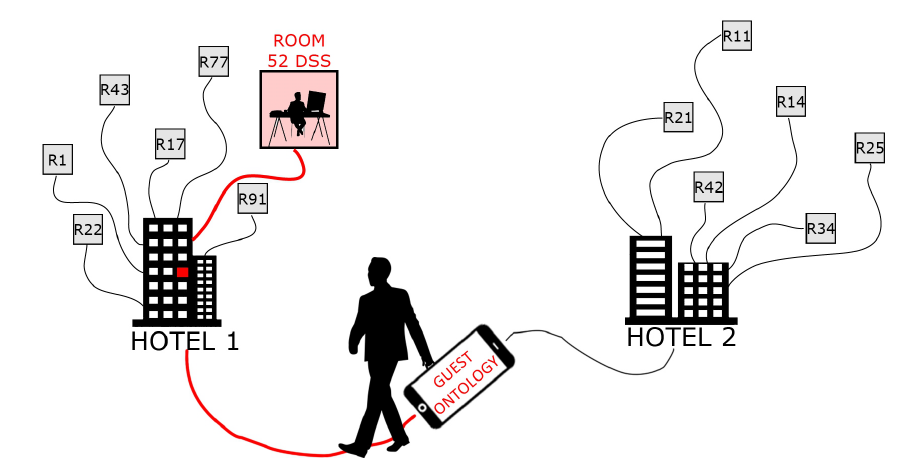
Figure 1. A schema describing the functioning of RoomFort: a business traveller can choose any hotel adopting the system and import his/her preferences.